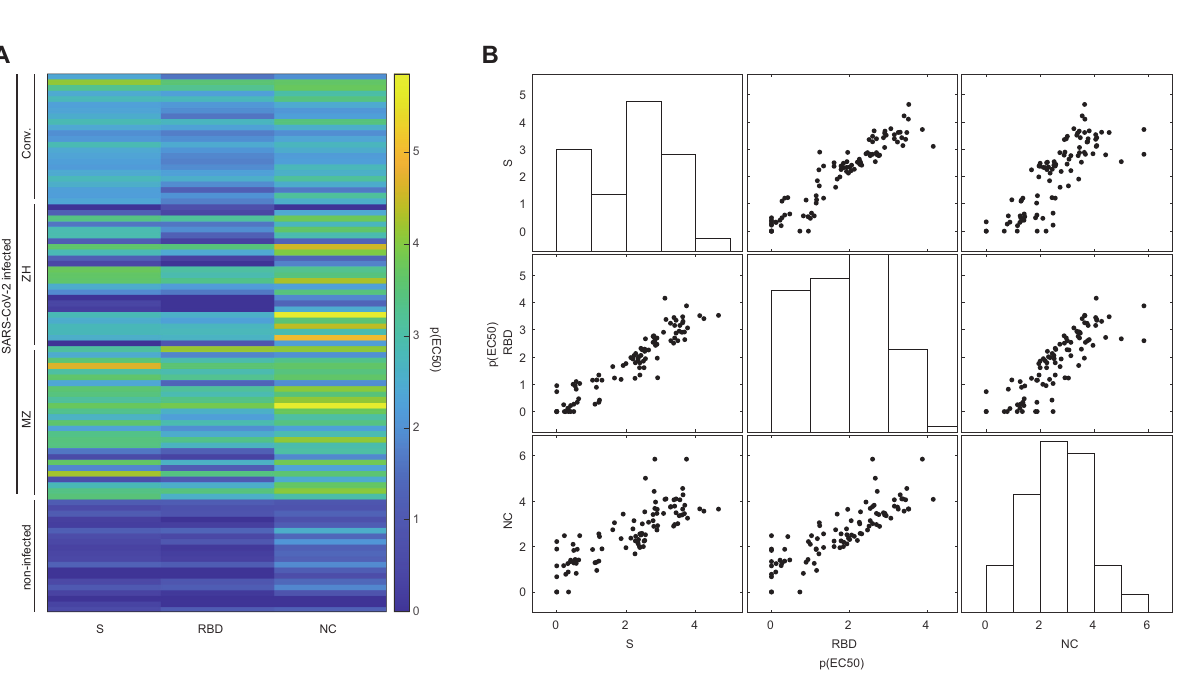
Fig 2. Antibodies against SARS-CoV-2 proteins using a tripartite autoimmune blood immunoassay. A . Colour-coded representation of the IgG antibody reactivity profile of non-infected controls and SARS-CoV-2 infected individuals for the SARS-CoV-2 spike protein (S), its receptor binding domain (RBD), and the nucleocapsid protein (NC). The p(EC50) value of the respective sample dilution reflects the inflection point of the logistic regression. B . Multicollinearity plot to display the individual reactivity profile of distinct anti-SARS-CoV-2 IgG antibodies. Antibodies against S, RBD, and NC are approximately linear against each other, indicating that information of one is predictive for the other. Bars represent the respective distributions of p(EC50) values obtained for S, RBD, or